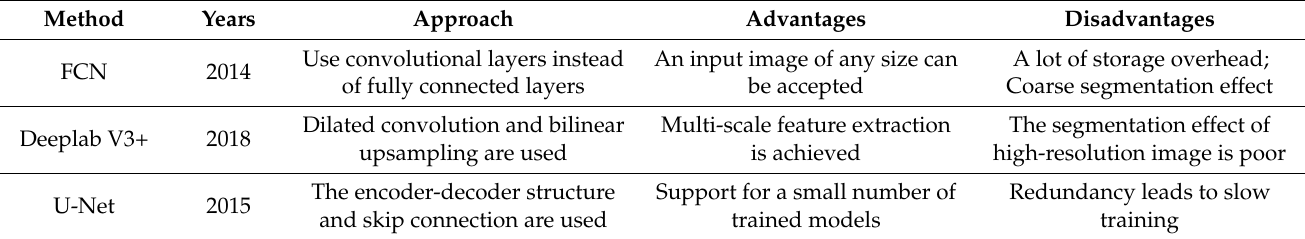
Table 1. Summary of papers mentioned in related